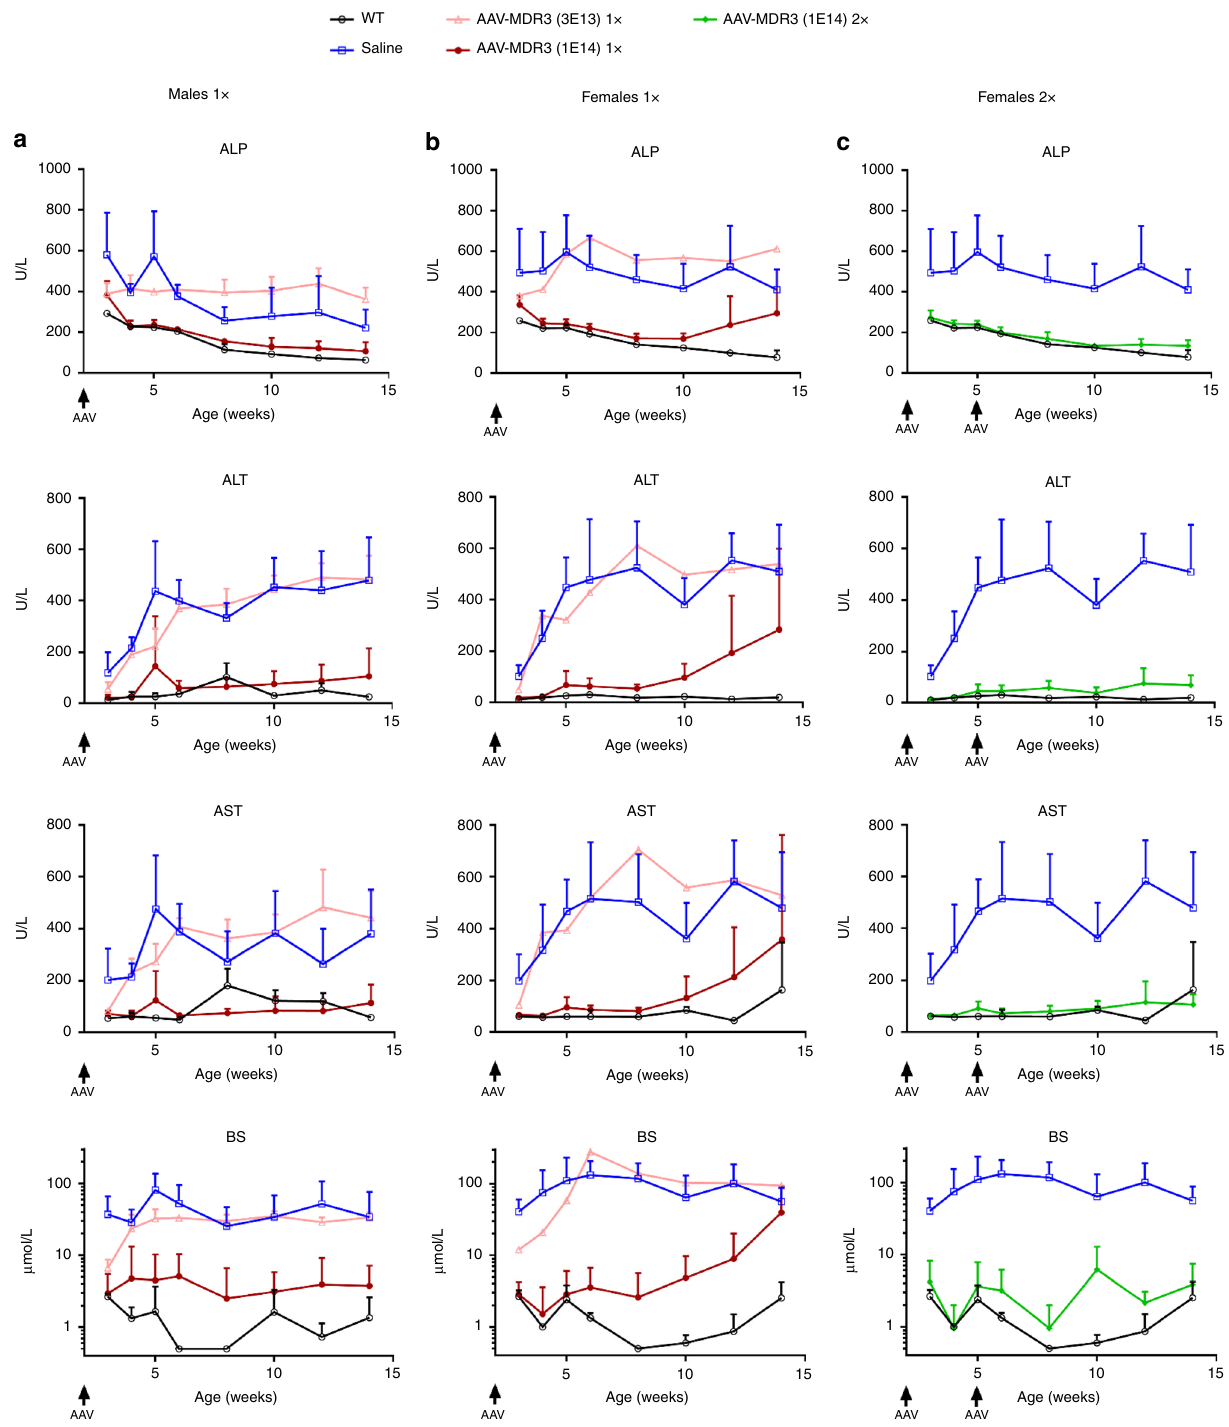
Fig. 3 Serum biomarker levels for AAV-MDR3-Aco-treated Abcb4 − / − mice through 12 weeks. The therapeutic effect of AAV treatment is shown in males ( a ) and females ( b & c ) that were treated with AAV-MDR3-Aco at 3 × 10 13 VG/kg one time (1×, pink, open triangles; n = 3 M (males)/1 F (females)), at 1 × 10 14 VG/kg one time (1×, red, fi lled circles; n = 7 M/6 F), or at 1 × 10 14 VG/kg two times (2×, green, fi lled diamonds; n = 5 F) using as controls saline-treated (blue, open squares; n = 4 M/8 F) and untreated Abcb4 + / + (WT) mice (black, open circles; n = 3 M/3 F). Data are presented as mean + SD. ALP alkaline phosphatase, ALT alanine transaminase, AST aspartate transaminase, BS bile salts. Source data are provided as a Source Data fi